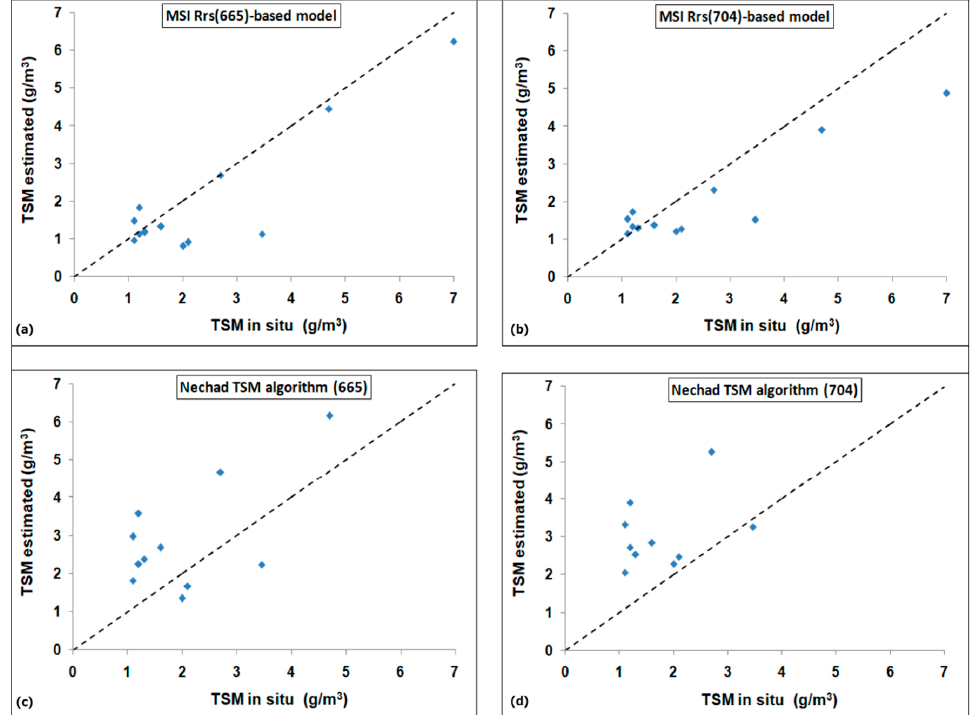
Figure 7. TSM match-up analysis within the validation dataset. ( a ) TSM model based on Rrs at 665 nm. ( b ) TSM model based on Rrs at 704 nm. ( c ) Nechad et al. [55] TSM algorithm based on Rrs at 665 nm. ( d ) Nechad et al. [55] TSM algorithm based on Rrs at 704 nm. The dashed line is the 1:1 line.